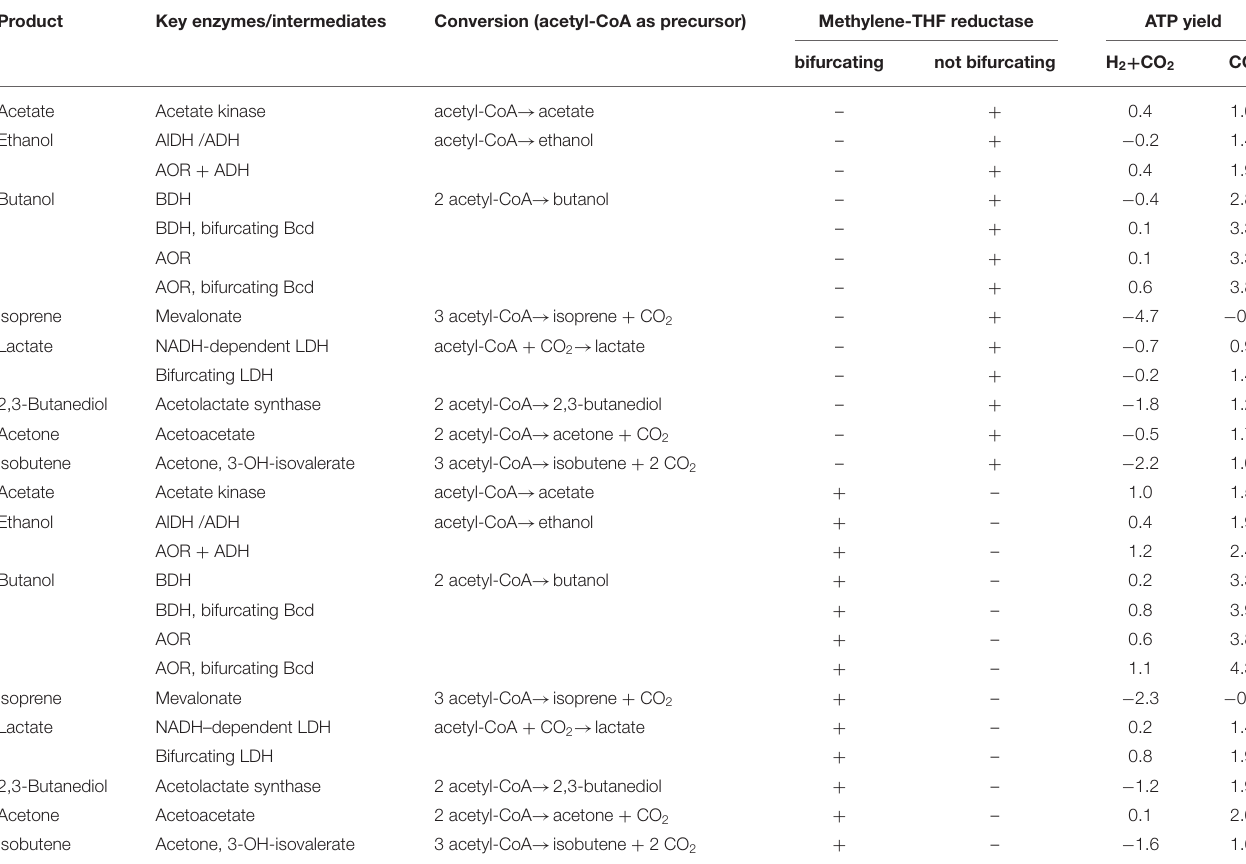
TABLE 2 | ATP yield for the synthesis of products from acetyl-CoA with H 2 + CO 2 or CO as electron donor in C. autoethanogenum . Product Key